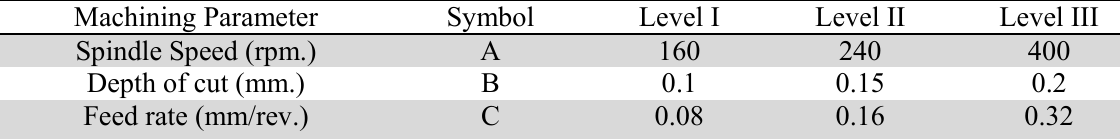
Input parameters and their levels Machining Parameter Symbol Spindle Speed (rpm.)